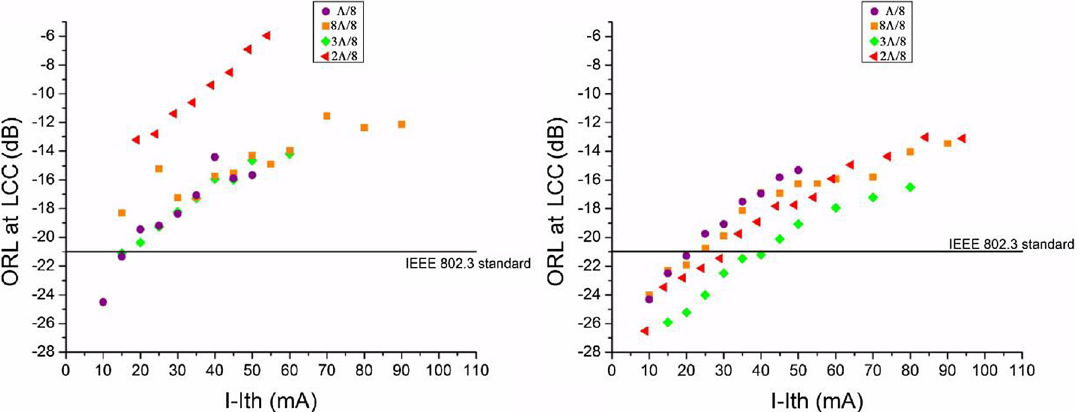
Figure 7: Direction-dependent resistance to external feedback of complex-coupled (CC) Distributed Feedback laser diodes (DFB) lasers cleaved from the same 1980 µm length bar and with differing grating phase shifts as function of the difference between the injection current I and the threshold current I_th. Sample 2 Λ /8 corresponds to a quarter period phase shift between the gain and loss gratings. The left graph is for probing from one side of the chip, the right graph is from the other